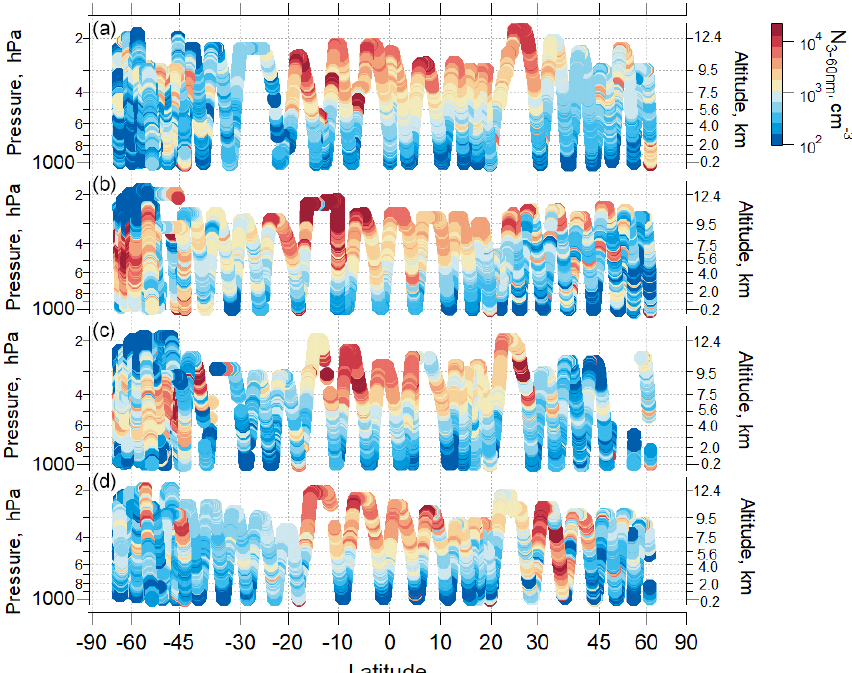
Figure 2. Ambient pressure as a function of latitude colored by the measured number concentration of particles with D p from 3–60nm over the Pacific Ocean for (a) ATom 1, July–August 2016; (b) ATom 2, January–February 2017; (c) ATom 3, September–October 2017; and (d) ATom 4, April–May 2018). Periods of flight in clouds, over continents, and near airports have been